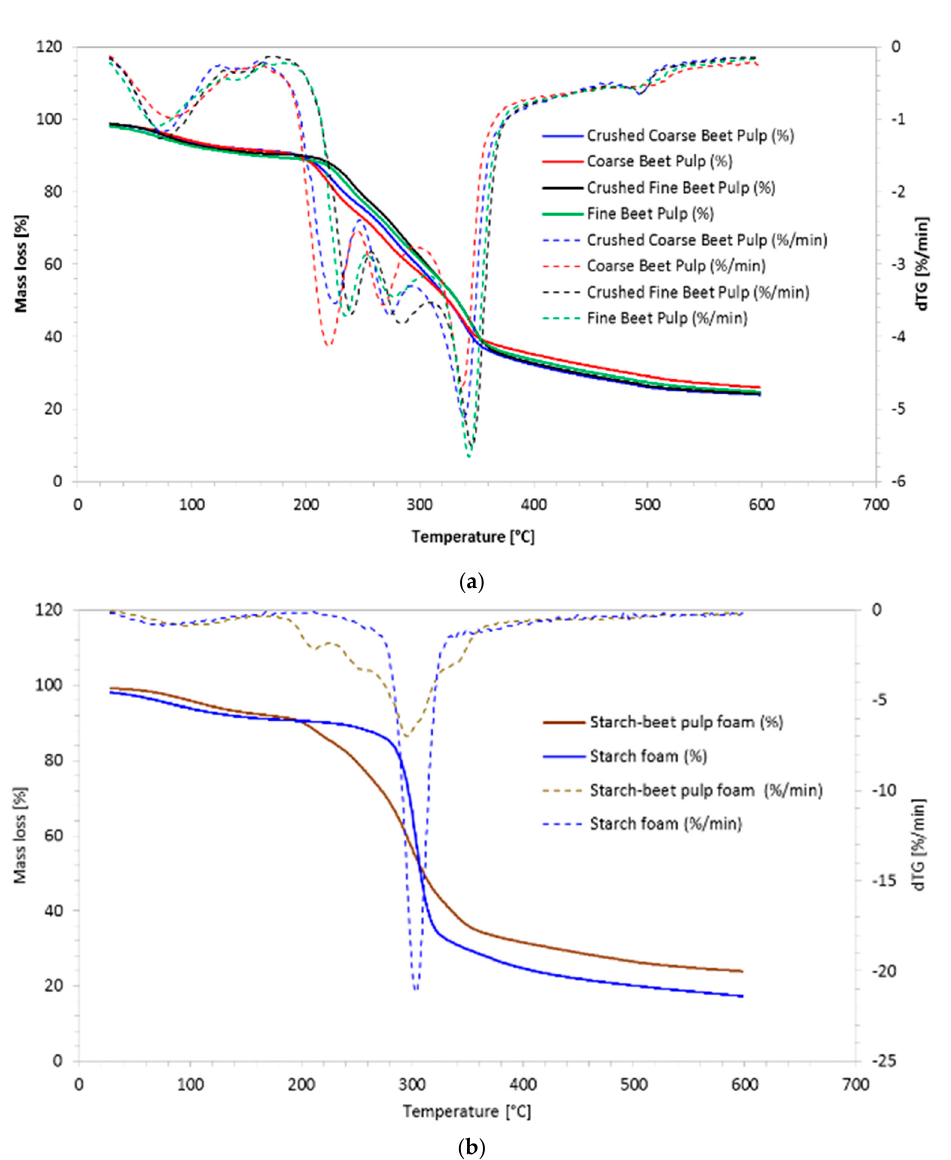
Figure 11. TGA thermograms: ( a ) beet pulps; ( b ) starch and starch-beet pulp foams.